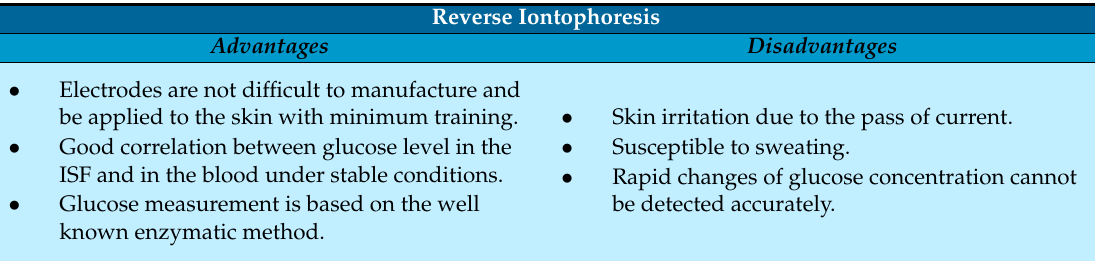
Table 22. Advantages and disadvantages of Reverse iontophoresis.